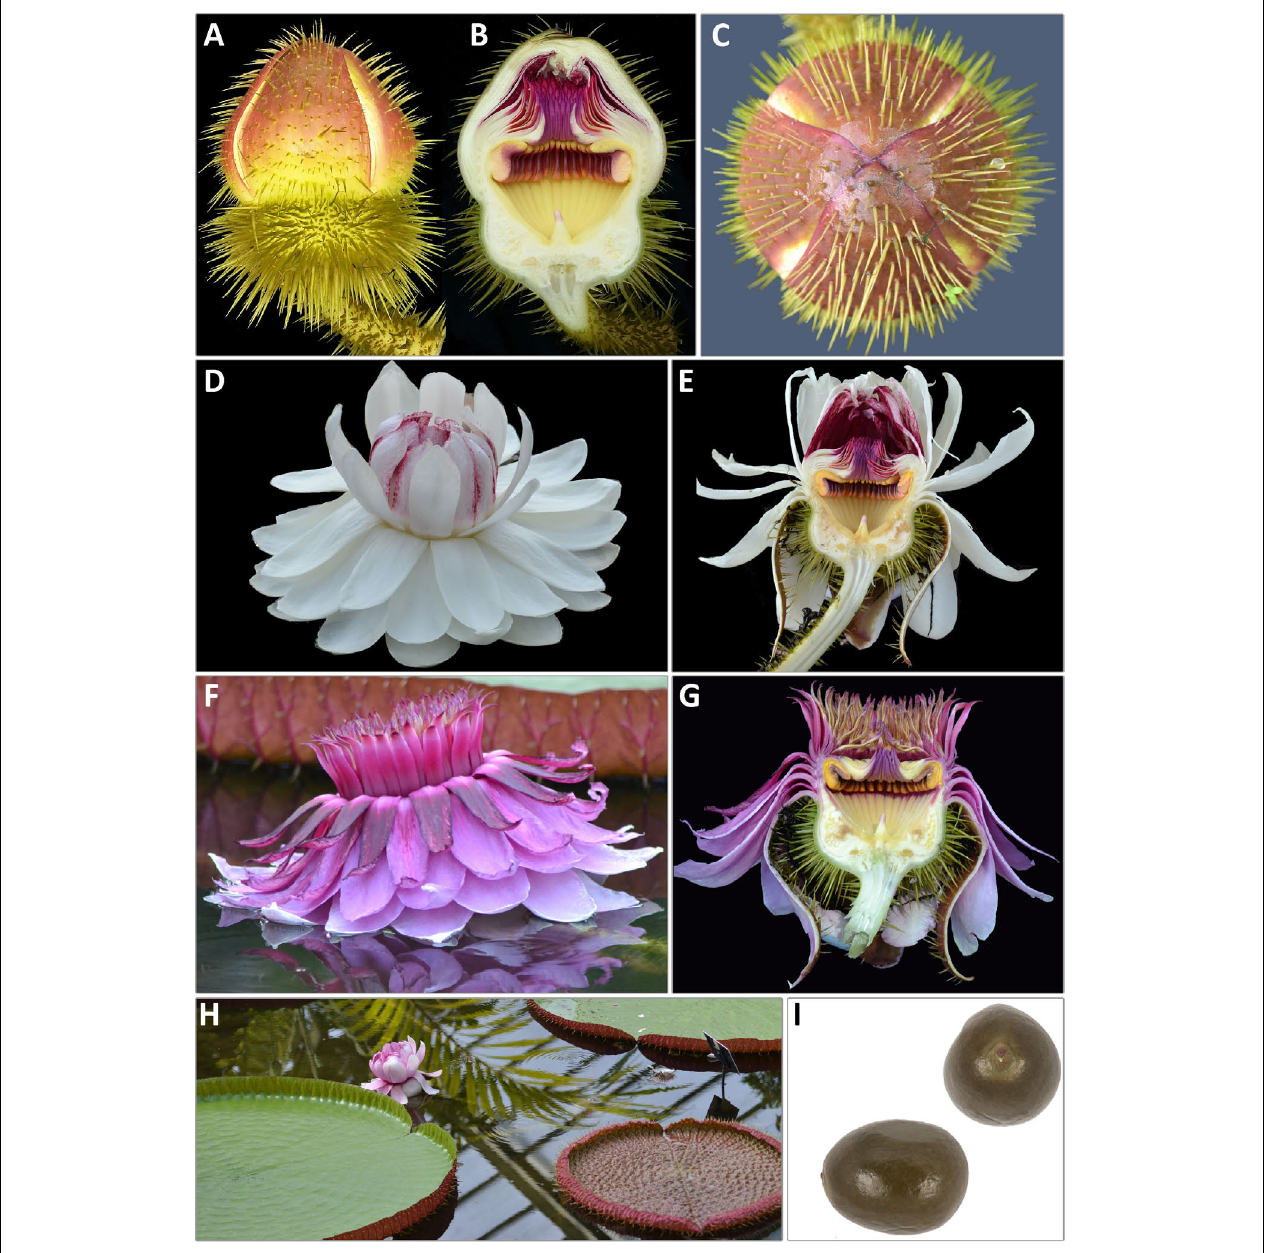
FIGURE 9 | Victoria amazonica (A) bud whole, (B) bud L.S., (C) bud from above, (D) first night flower, (E) first night flower L.S., (F) second night flower, (G) second night flower LTS, (H) habit, and (I) seed. (A–H) (LTS) and (I) (CM) cultivated RBG Kew.